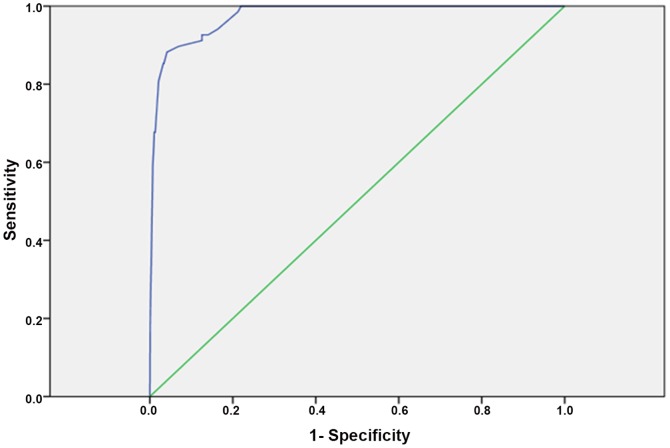
ROC curve analysis for the association of the modified DIC score with the development of DIC.